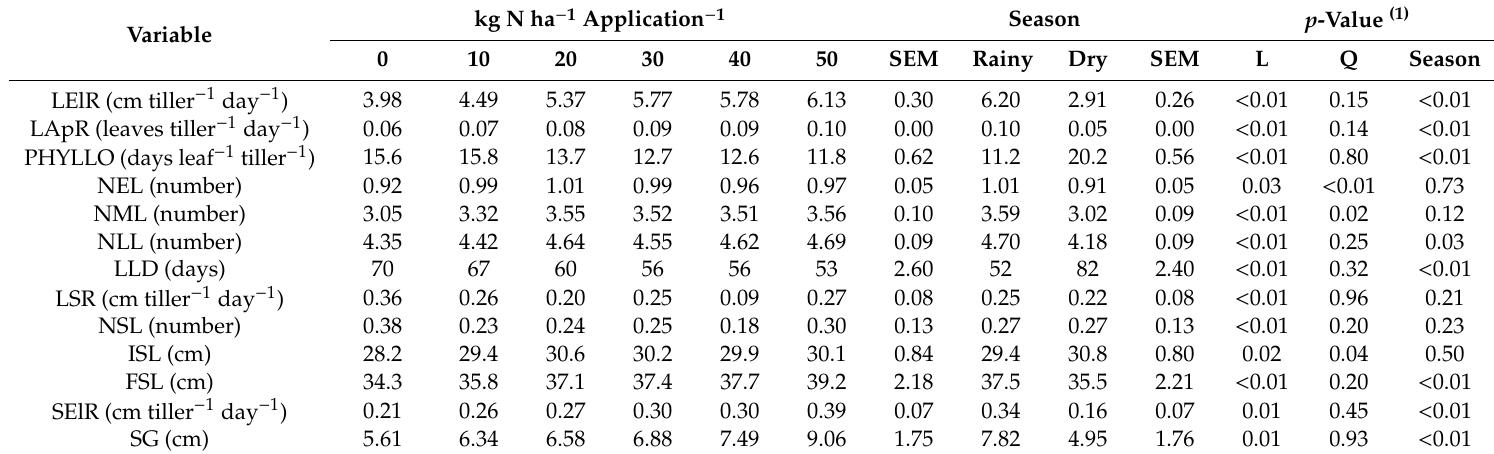
Table 2. Morphogenic characteristics of Guinea